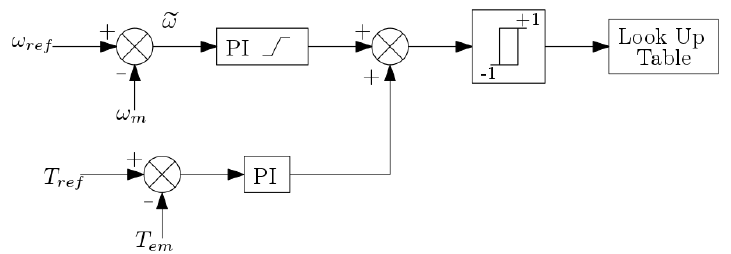
Figure 4. Block diagram of a parallel PI controller.